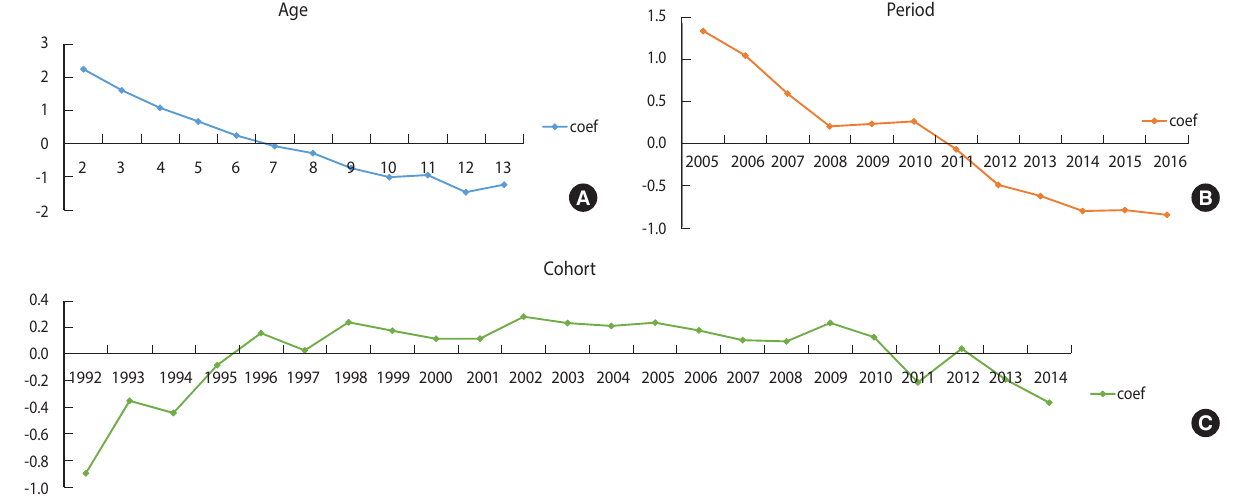
Figure 2. Intrinsic estimator (coef) of age (A), period (B), cohort (C) effect from annual age-specific crude incidence rates (1,000 person) of varicella by age (2-13 years old) and calendar year (2005-2016) in children in Jeju-do, Republic of Korea.